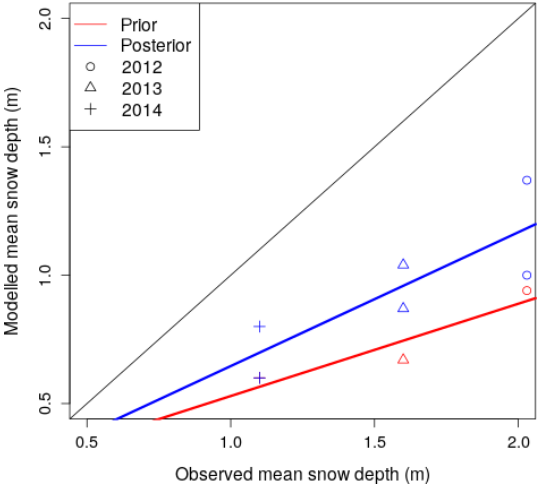
Figure 8. Interannual validity of weights generated by the DA scheme. Modelled versus observed mean snow depth averaged over the entire ADS zone on ADS acquisition dates WY2012, WY2013 and WY2014 are shown. Posteriors (blue) are generated using the weights of the other 2 years and are compared to the prior (red). For example, posteriors of WY2012 are generated using weights of WY2013 and